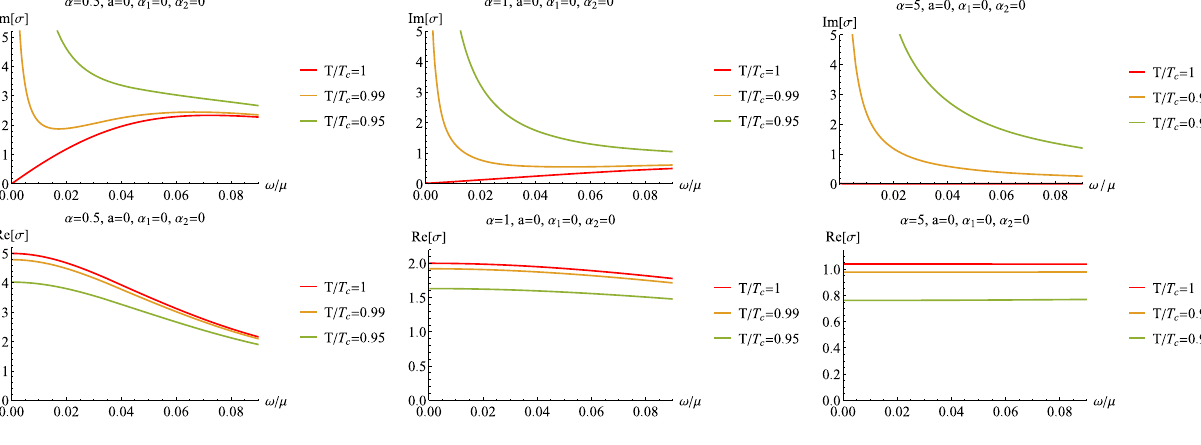
Fig. 6 The critical behavior of the conductivity near the critical temperature in the low frequency region for the different α . We have turned off other coupling parameters. Here we have abbreviated the two dimensionless quantities { T /μ,α/μ } to { T ,α } Table 1 The normal fluid density n n in the superconducting phase for the different temperature with different α . Here we turned off other coupling parameters and the dimensionless quantity { α/μ } is abbreviated as { α